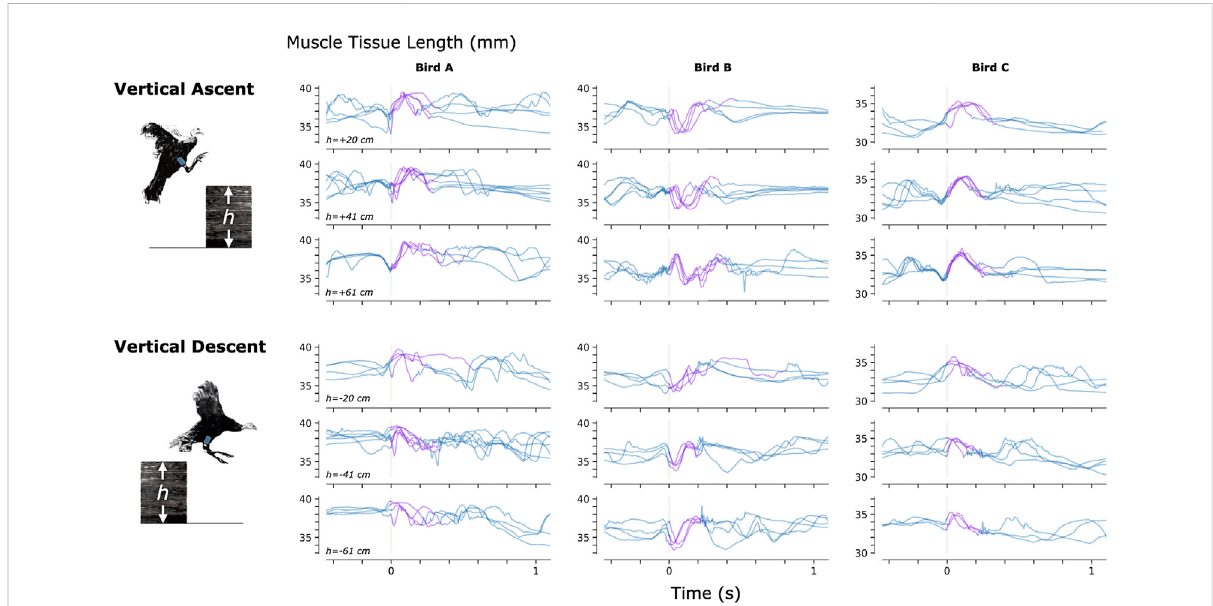
FIGURE 4 Muscle Tissue Length During Non-Synchronous Vertical Ascent and Descent. We used magnetomicrometry to track muscle tissue length during vertical ascentanddescentatthreeheightsforall threebirds. Data foreach birdandeach heightaresynchronizedatrightlegtoe-off(startof the aerial phase, indicated by the vertical gray line). Variability between curves re fl ects movement variability during untrained vertical ascent and descent. Muscle tissue length during contact with the ground is plotted in blue, and muscle tissue length during the aerial phase is plotted in purple. All data are shown, including scenarios in which signi fi cant wing- fl apping occurred during jump up or down. We captured at least three recordings of each activity for each bird.